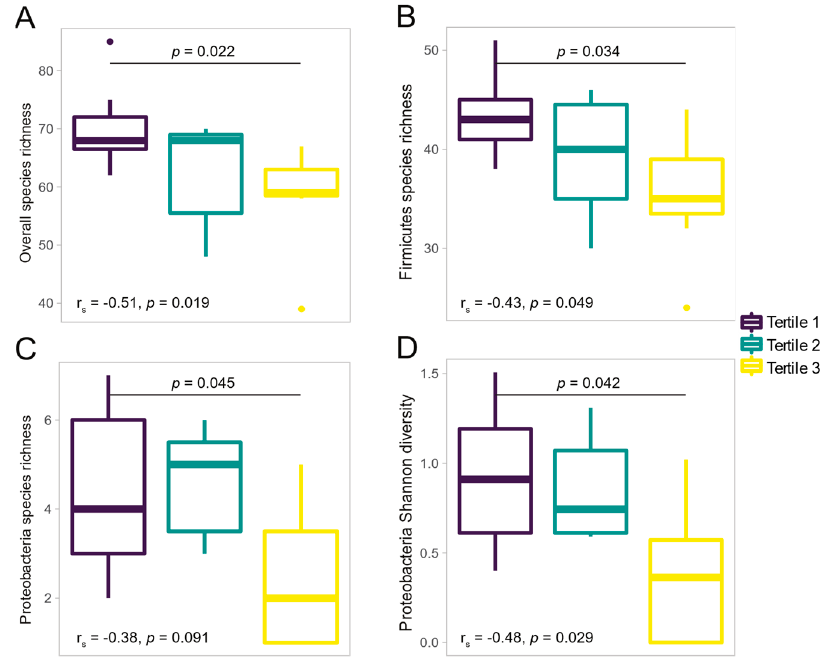
Figure 1. Boxplots of α -diversity indices stratified by homeostatic model assessment for insulin resistance (HOMA-IR) tertiles (N = 21). ( A ) Overall species richness; ( B ) Firmicutes species richness; ( C ) Proteobacteria species richness; and ( D ) Proteobacteria Shannon diversity. Comparisons between HOMA-IR tertiles were performed using the Dunn’s test with Benjamini − Hochberg correction.